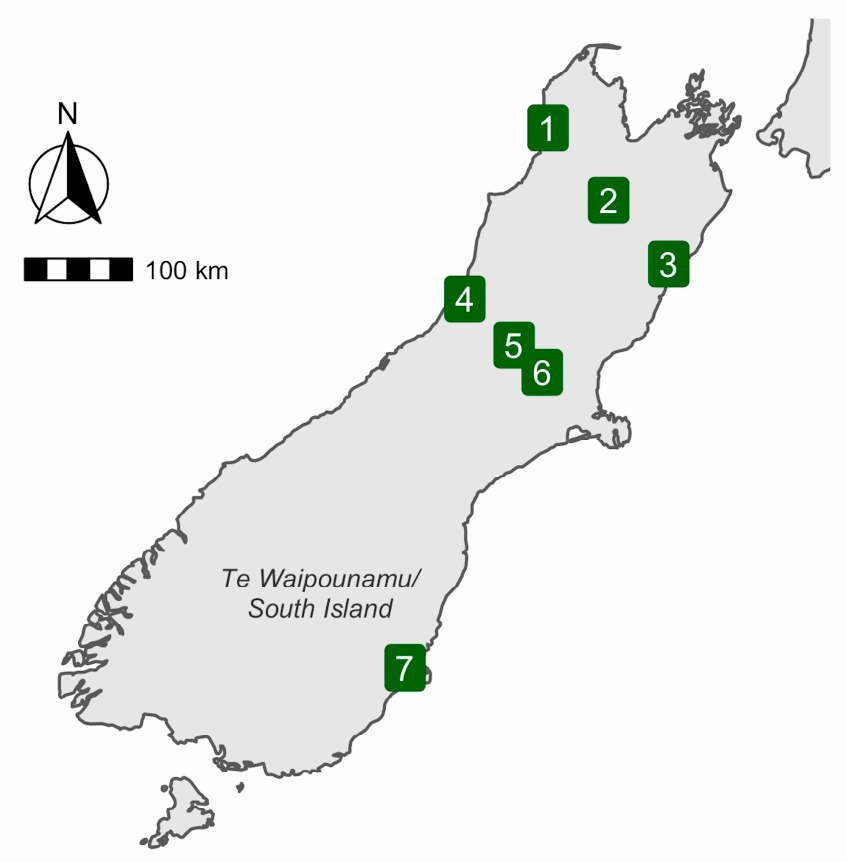
Figure 1. Map of the South Island/Te Waipounamu, New Zealand. Location of mist net sites shown as numbered green